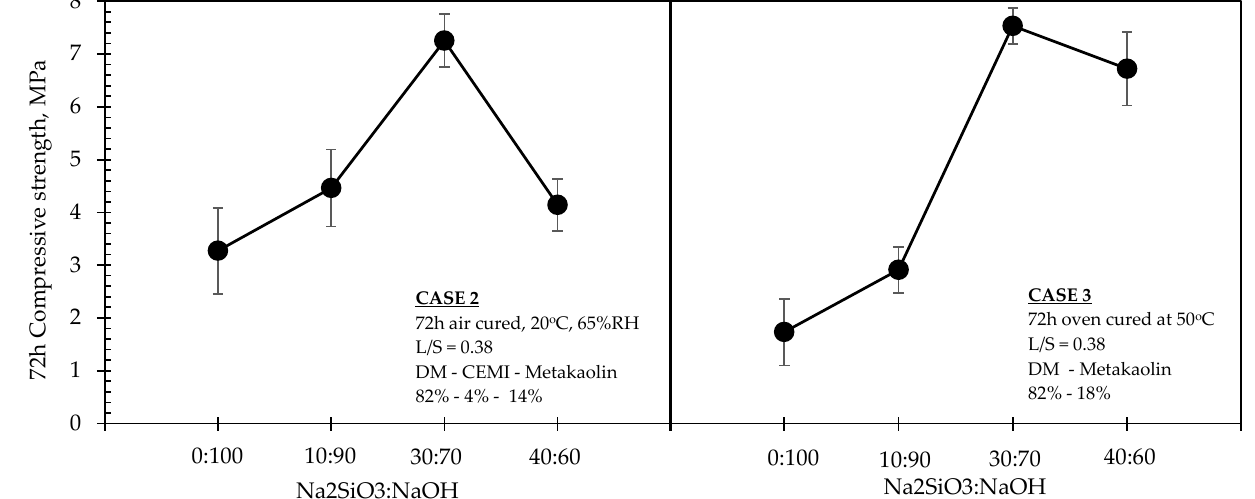
Figure 7. Effect of Na 2 SiO 3 : NaOH ratio on the 72 h strength of formulations in Cases 2 ( left ) and 3 ( right ), for M NaOH = 10.